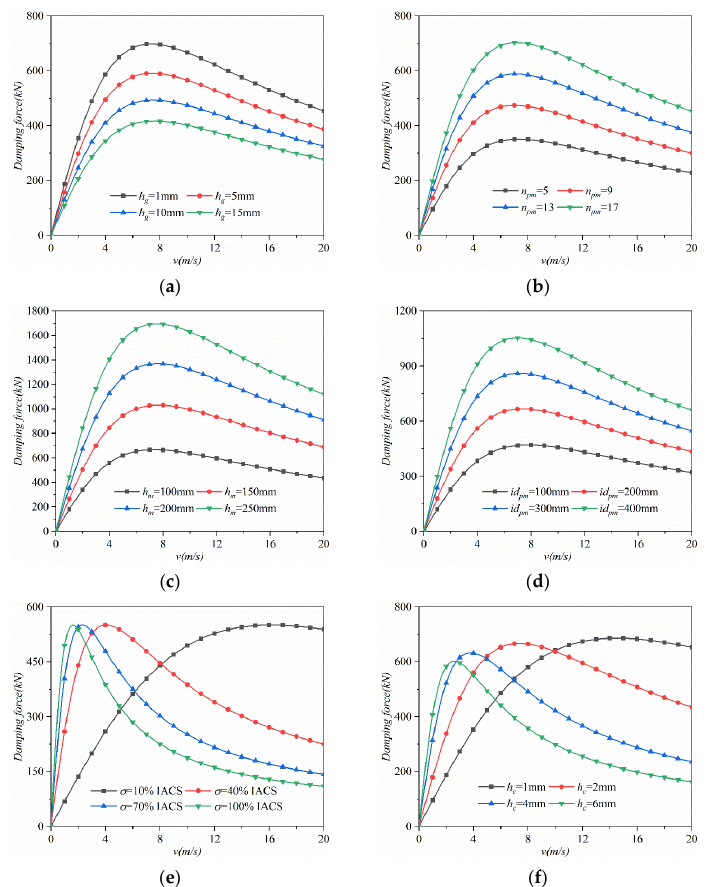
Figure 12. Influence of physical design parameters of the ECD on its constitutive behavior: ( a ) Damping force versus the radial height of air gap; ( b ) Damping force versus the number of PM rings; ( c ) Damping force versus the radial height of PM rings; ( d ) Damping force versus the radial inner diameter of PM rings; ( e ) Damping force versus the conductivity of conductor; and ( f ) Damping force versus the radial height of conductor.